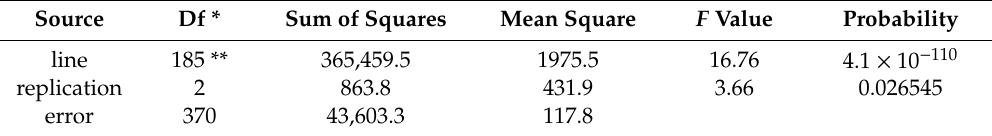
Table 1. Analysis of variance (ANOVA) of seedling mortality rate.